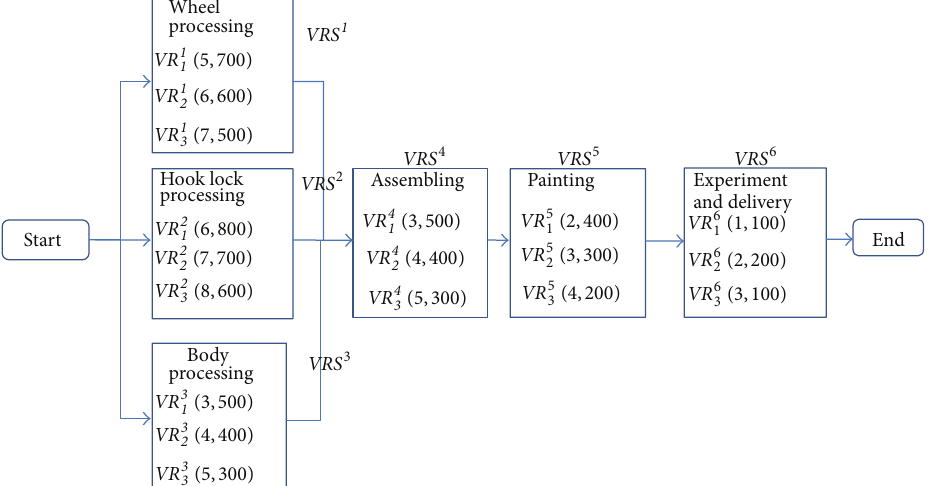
Figure 1: Manufacturing process of C70E open wagon.